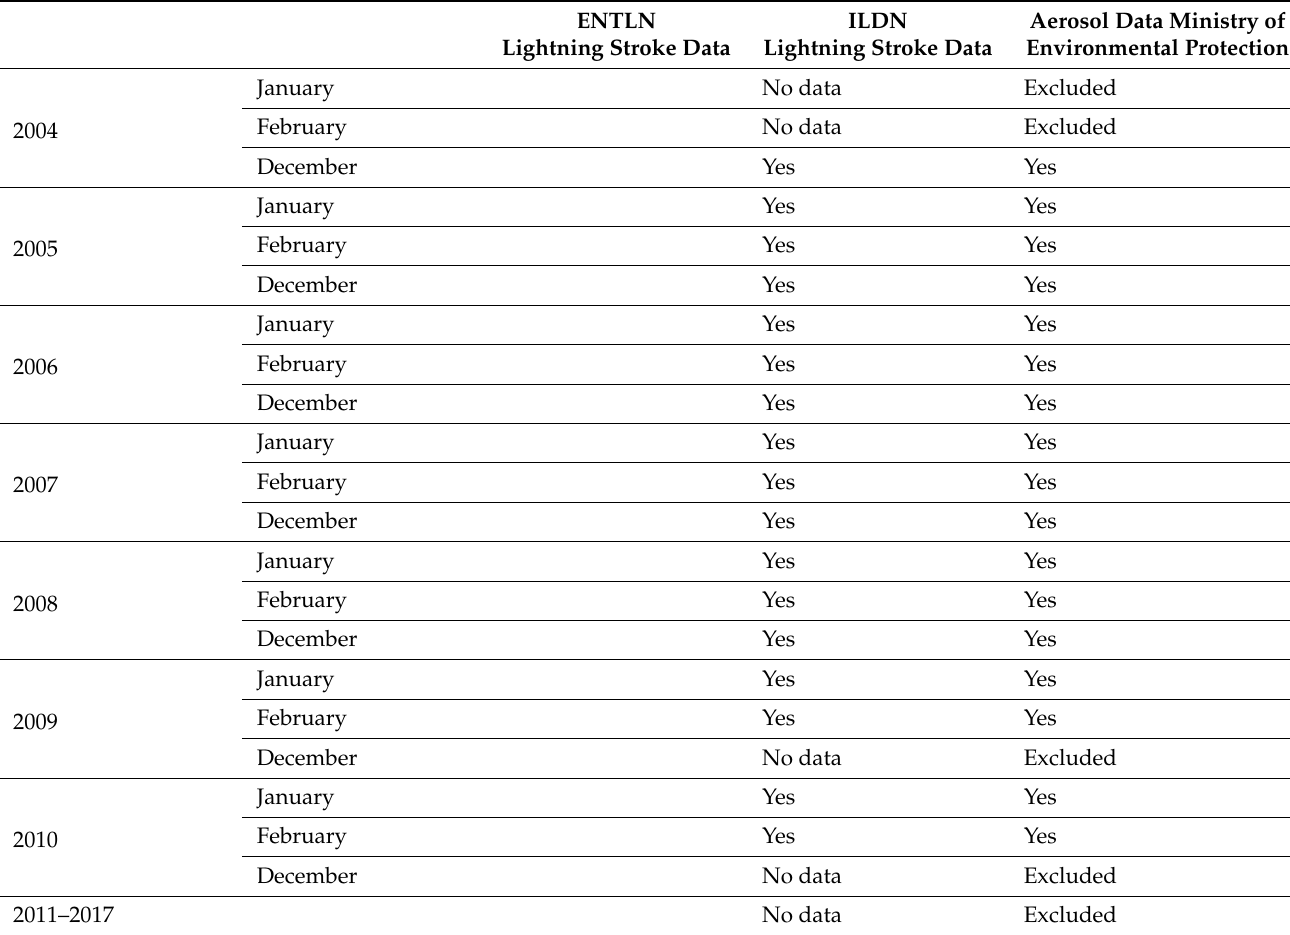
Table A1. Lightning and aerosol data